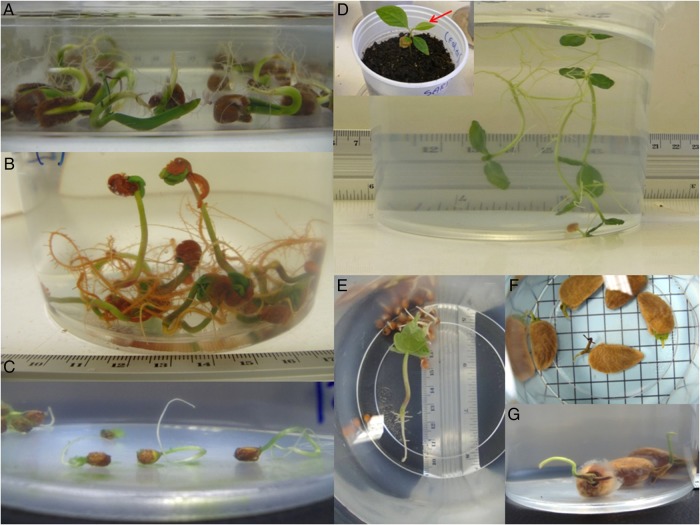
Germinated seeds and seedlings formed in water. (A) Crataeva tapia; (B) Eugenia inundata; (C) Laetia corymbulosa; (D) Genipa americana; (E) Pseudobombax munguba; (F) Simaba guianensis; (G) Pouteria glomerata. The arrow in the inset of (D) points to new leaves that flushed after the seedling was removed from water following a period of 90 days of submersion and transplanted into aerated soil.